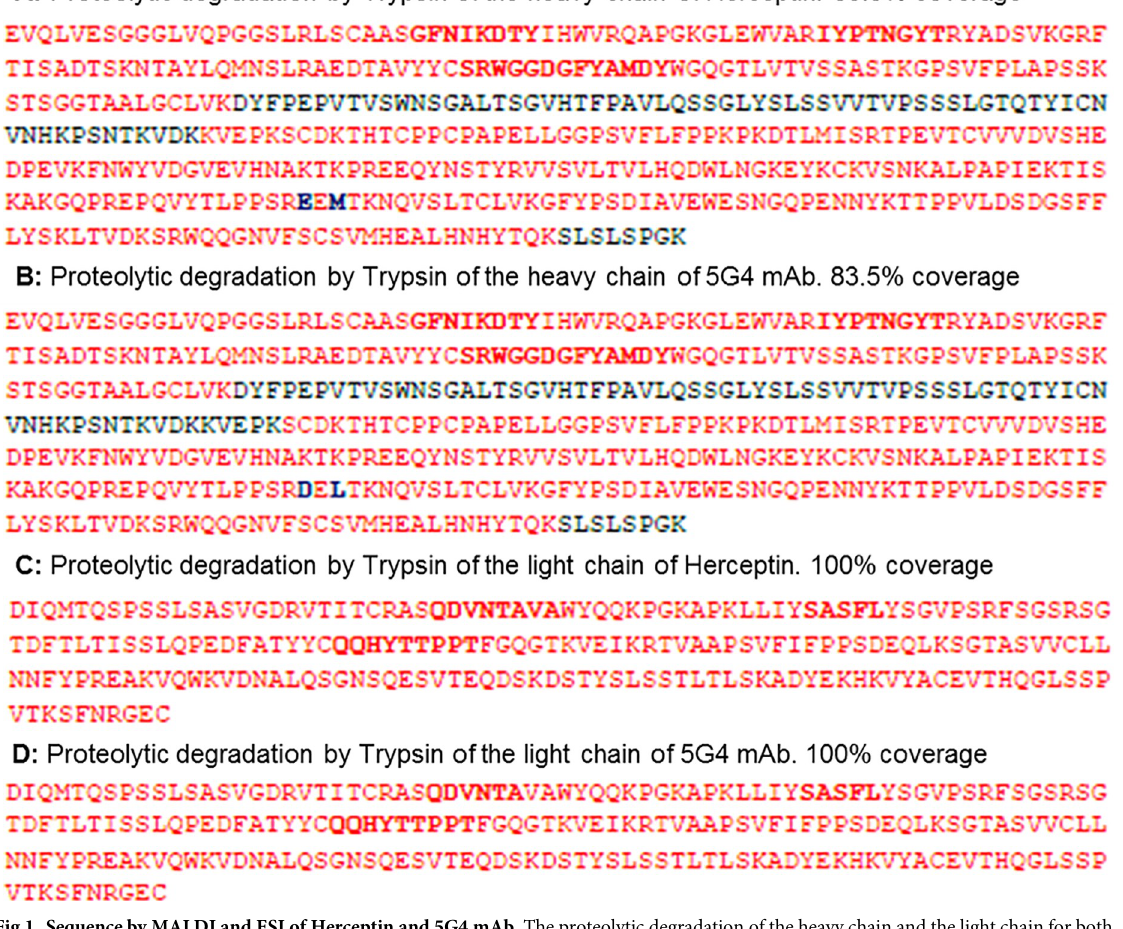
Fig 1. Sequence by MALDI and ESI of Herceptin and 5G4 mAb. The proteolytic degradation of the heavy chain and the light chain for both antibodies is observed. In red: mapped sequence, in black: sequence without mapping and highlighted in red: the complementarity determining regions. A and B: Proteolytic degradation by Trypsin of the heavy chain of Herceptin and 5G4 mAb, respectively. C and D: Proteolytic degradation by Trypsin of the light chain of Herceptin and 5G4 mAb, respectively.